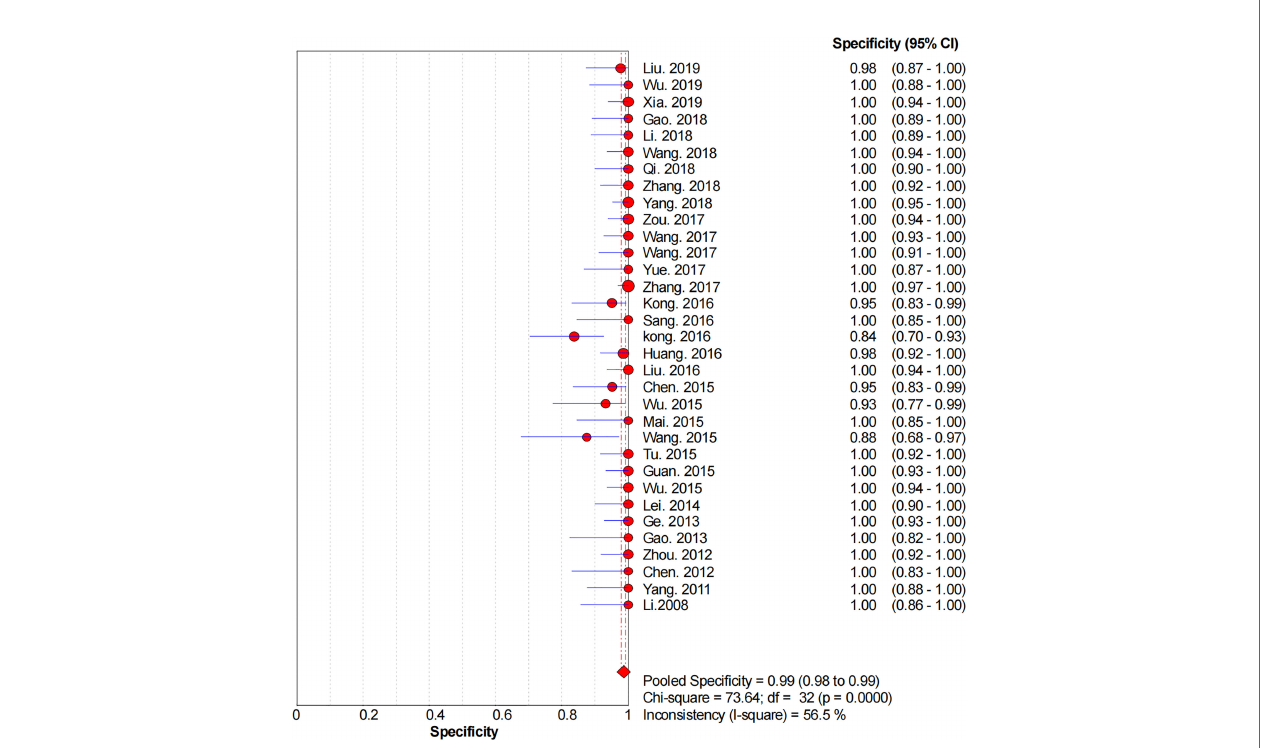
FIGURE 3 | Forest plot of pooled speci fi city of the diagnosis value of CNSs in SLNB of breast cancer. 95% CI, 95% con fi dence interval.